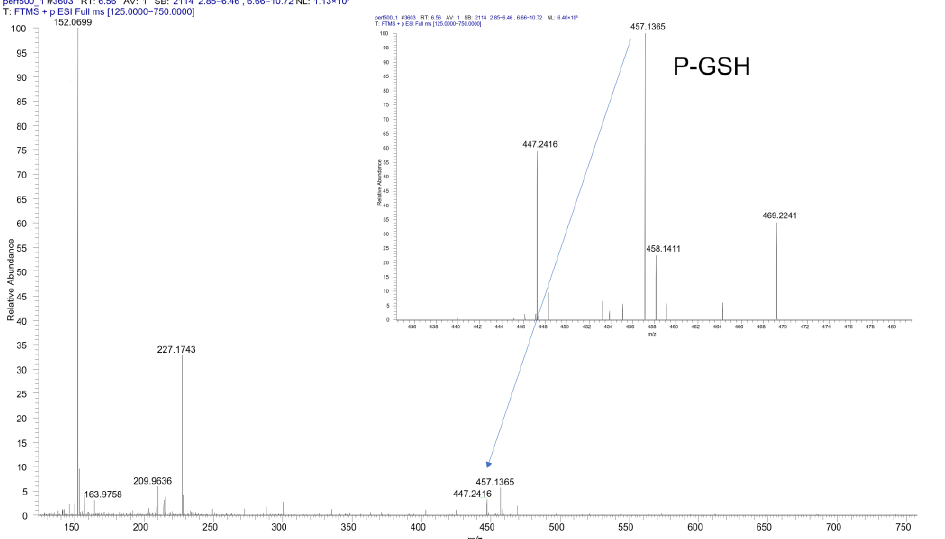
Figure A7. HRMS spectrum of paracetamol-glutathione generated in rat small intestine luminal after 90 min of perfusion.